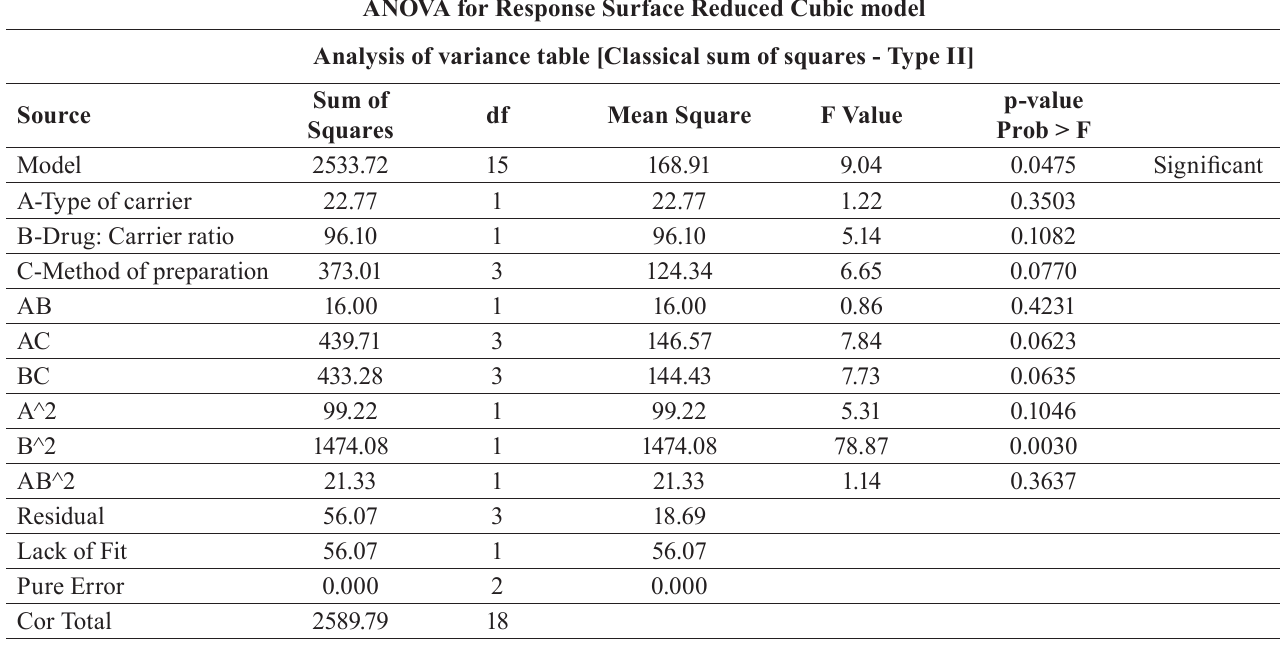
TABLE S4 - ANOVA table for the response variable drug release in 30 min along with the polynomial equation ANOVA for Response Surface Reduced Cubic model Analysis of variance table [Classical sum of squares - Type